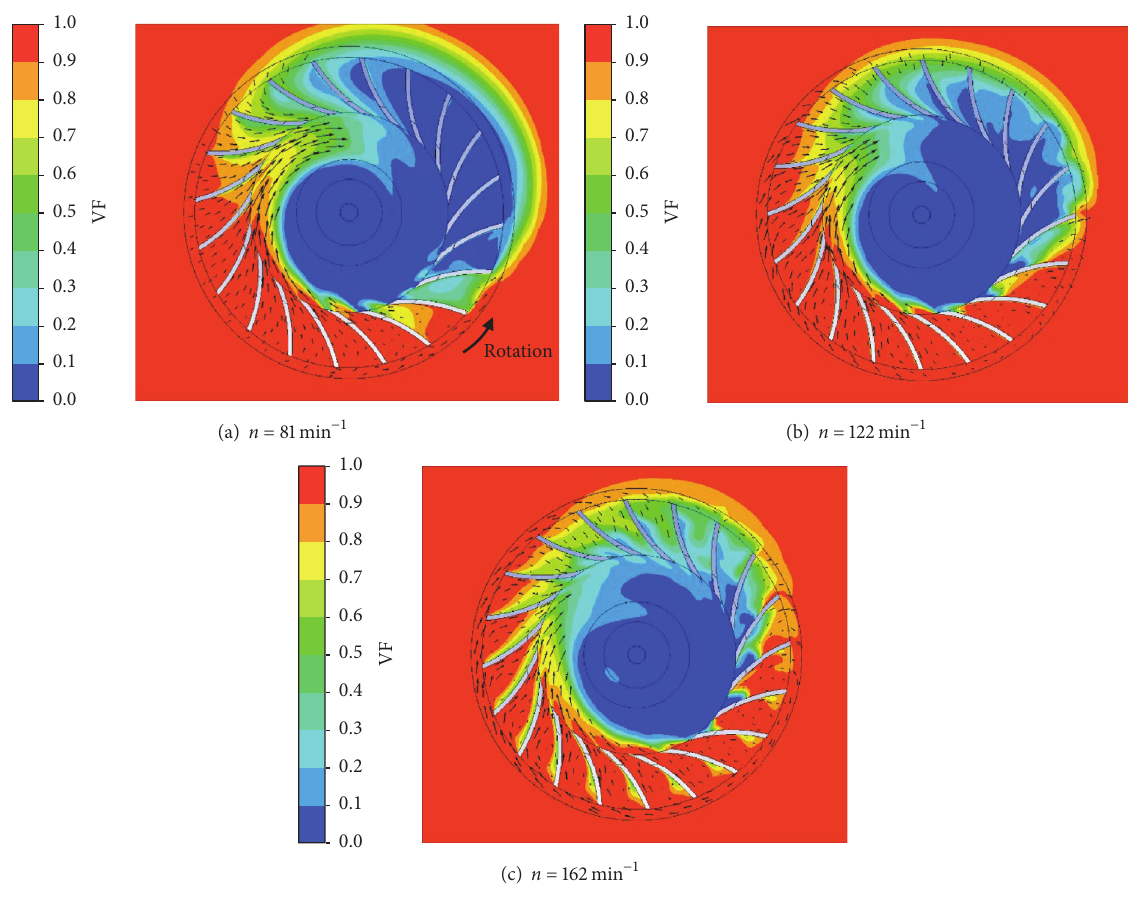
Figure 18: Relative velocity vectors and volume fraction of water